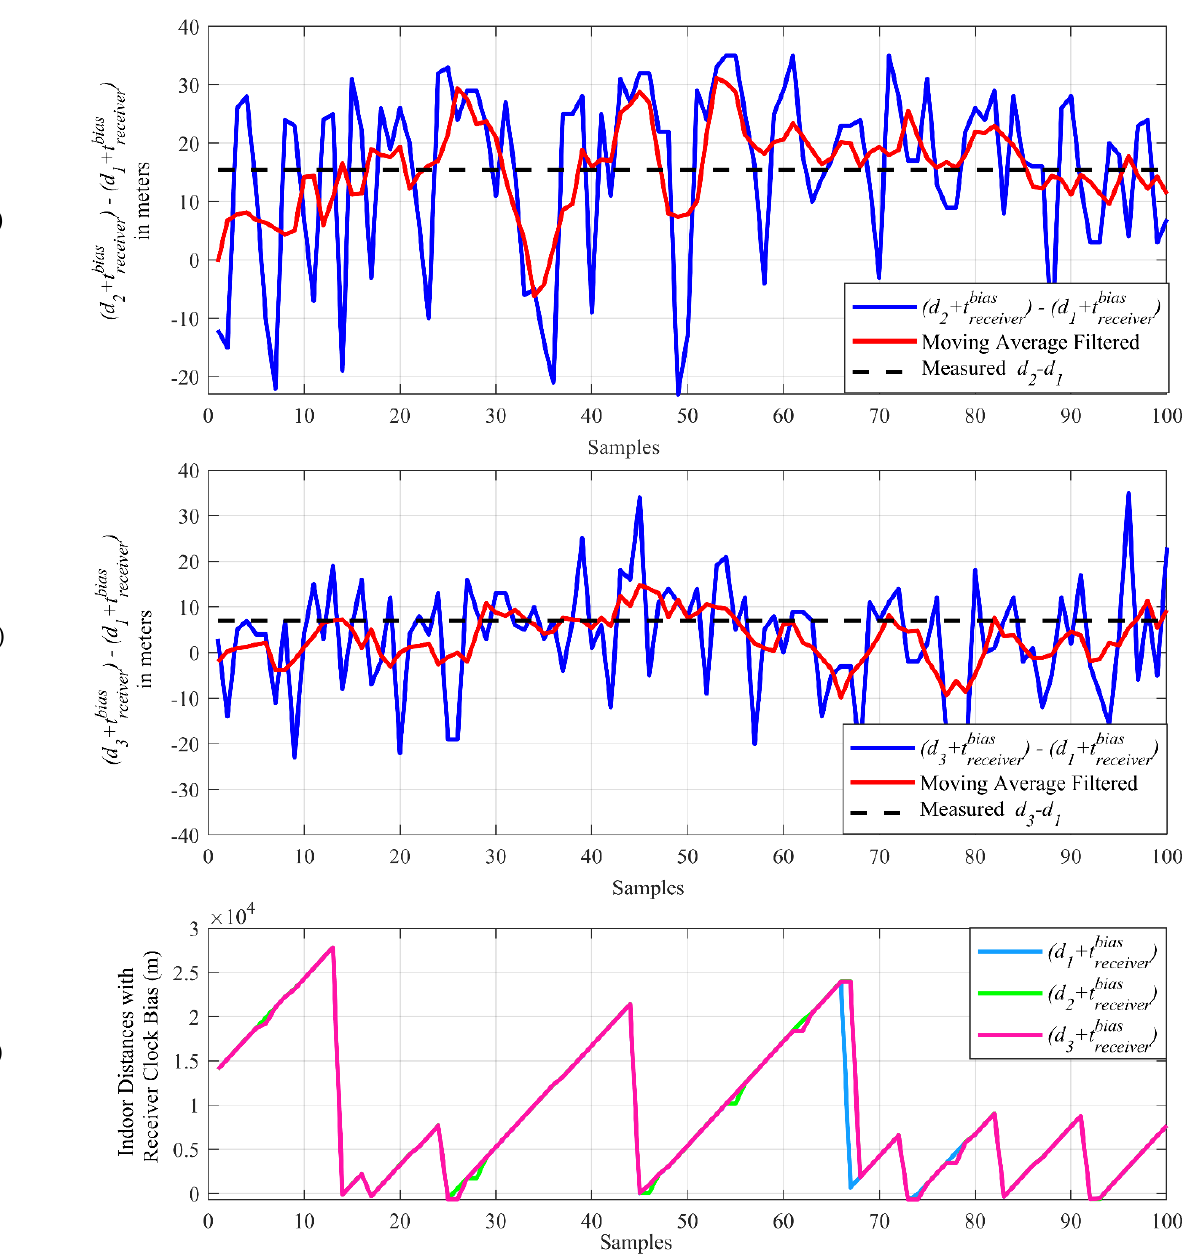
Figure 18. The indoor distance differences ( a , b ) and indoor distances with the receiver clock bias term ( c ).